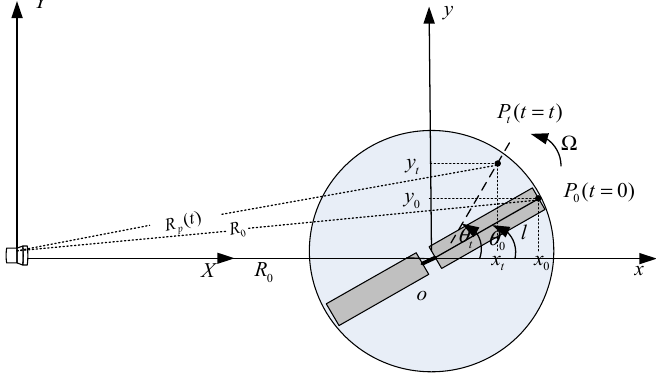
Figure 1. Geometric configuration between radar and UAV rotors.